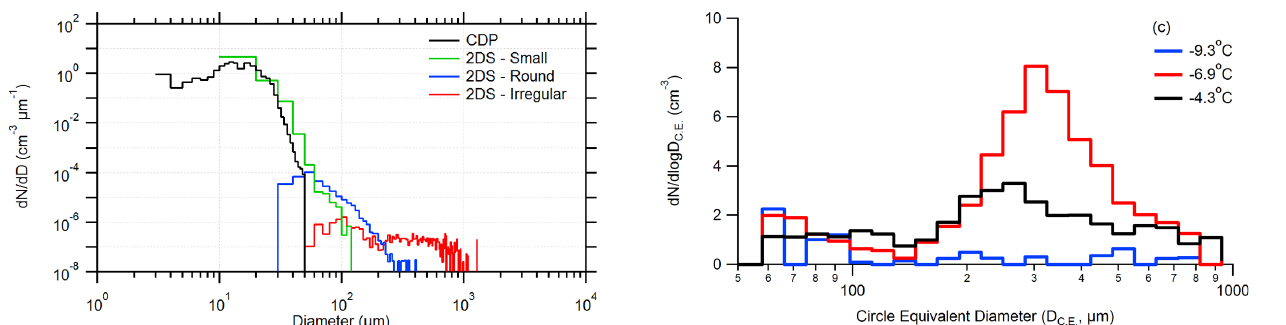
Fig. 12a. Average cloud particle size distribution from the FAAM aircraft. Data are from R2 in the supercooled layer cloud ( T =− 11 . 7 ◦ C, altitude = 3.48km) observed above CFARR.